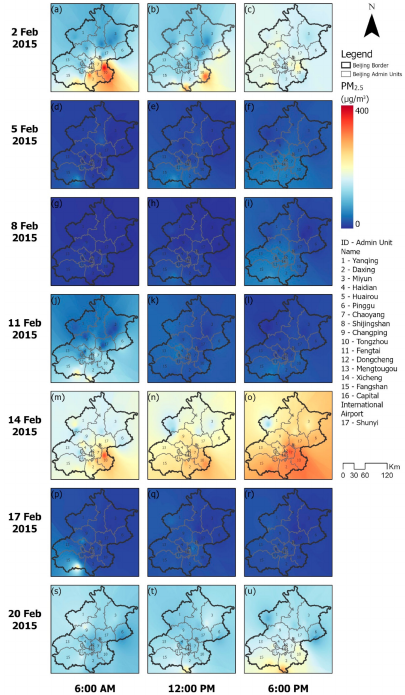
Figure A7. Twenty-one examples of the PM 2.5 distribution at different time points. In the layout of ( a – u ), every row shows the distributions of three time points: 6:00 a.m., 12:00 p.m., and 6:00 PM in the same day, while there are 7 days’ examples of date 2, 8, 11, 14, 17, and 20 in February